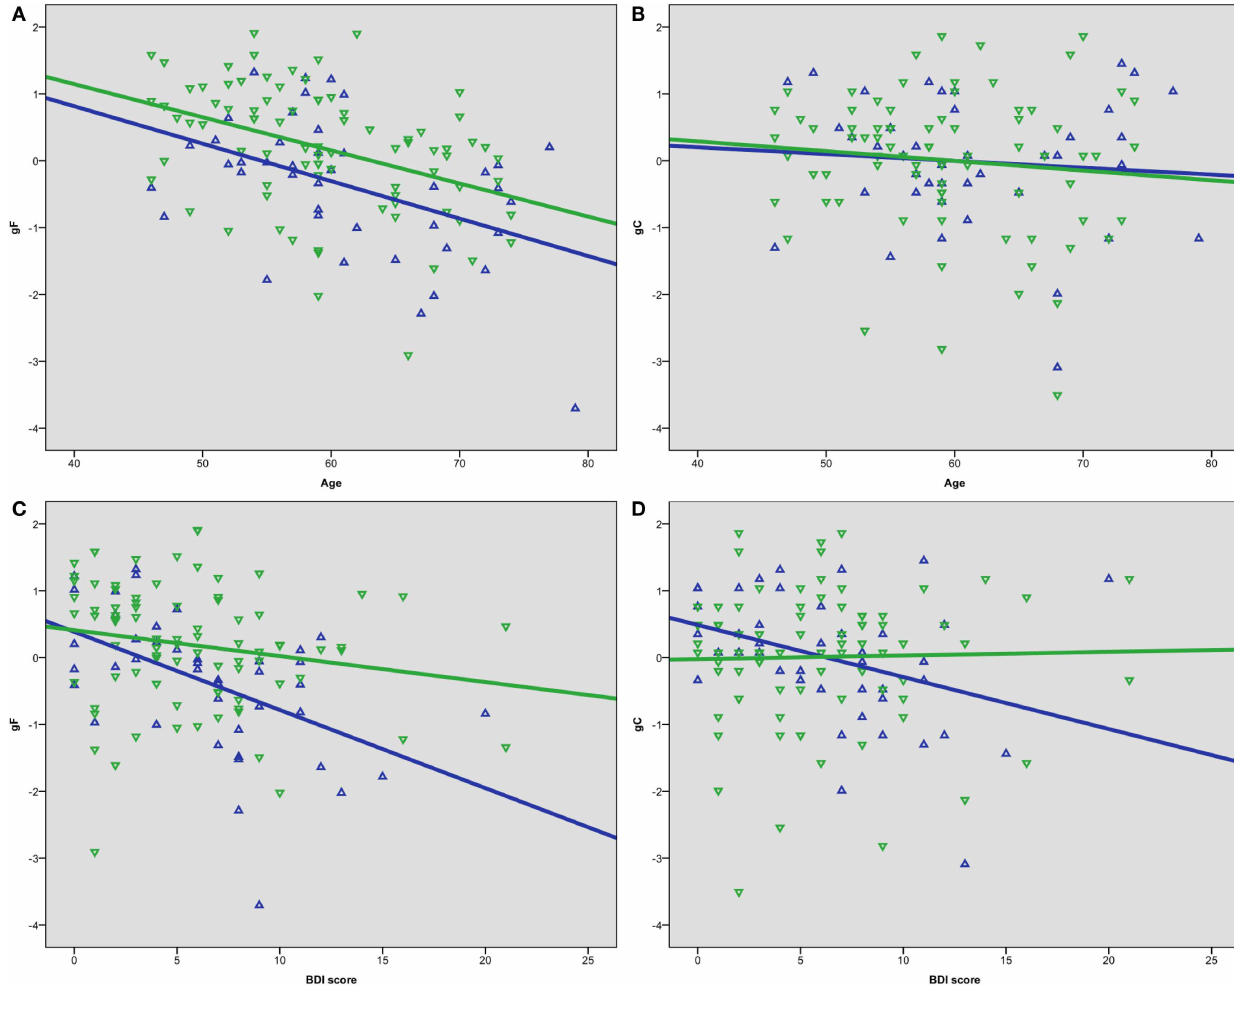
FIGURE 2 | Scatterplots of (A) age and gF, (B) age and gC, (C) BDI score and gF, (D) BDI score and gC . Green represents female, blue represents male.